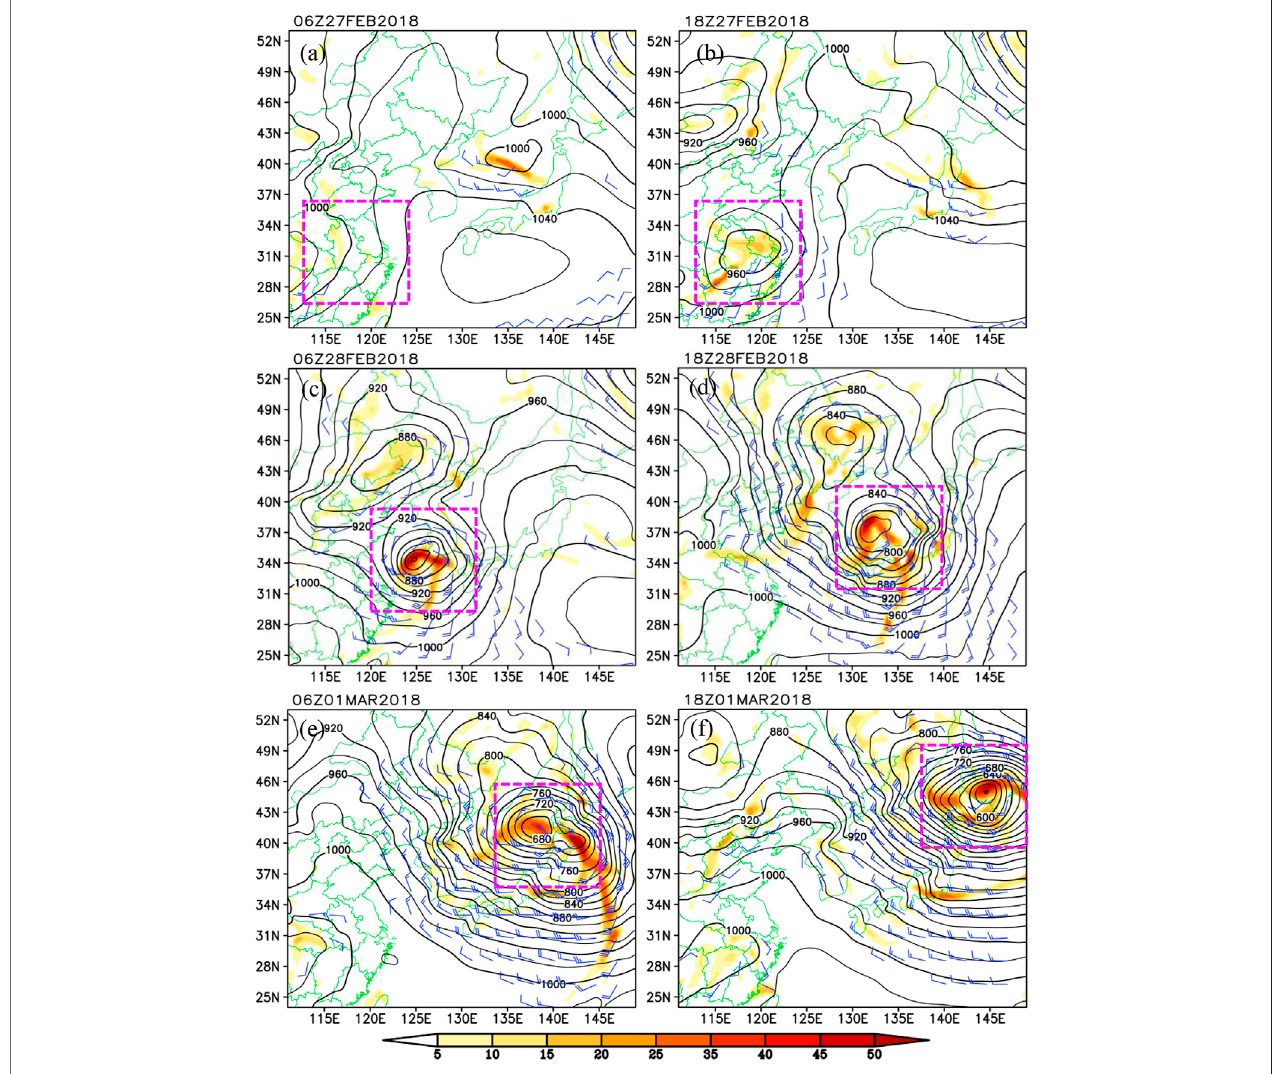
FIGURE 2 | Geopotential height (black solid lines; gpm), wind above 10 m s -1 (blue wind bar; a full bar is 10 m s -1 ), and cyclonic vorticity (shading; 10 -5 s -1 ) at 900 hPaat (A) 06ZonFeburary27,2018, (B) 18ZonFeburary27,2018, (C) 06ZonFeburary28,2018, (D) 18ZonFeburary28,2018, (E) 06ZonMarch1,2018, (F) 18Z on March 1, 2018, where the purple dashed boxes mark the central region of the explosive